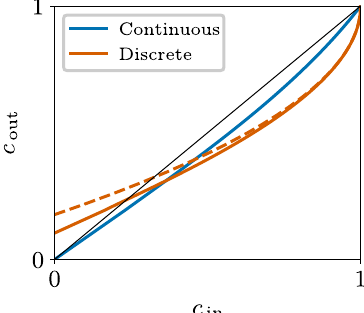
FIG. 13. Correlation transmission by a pair of neurons. Corre- lation coefficient c between outputs as a function of the out correlation coefficient c between inputs. Discrete signaling in [dark orange, Eq. (A44)]; continuous signaling [blue, Eq. (A41)]. → 1 (dashed Approximation for discrete signaling in the limit c in 1 dark orange) shows a behavior of the form ∝ − ð 1 − c 2 , so the in Þ − 1 slope diverges as ∝ ð 1 − c 2 . For comparison: identity map- in Þ ping with unit slope (black